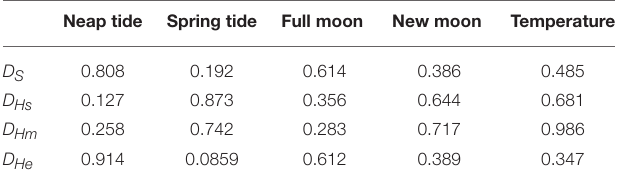
TABLE 3 | P -values for relationships between environmental events and hatching and spawning using the statistical test outlined in the Material and Methods